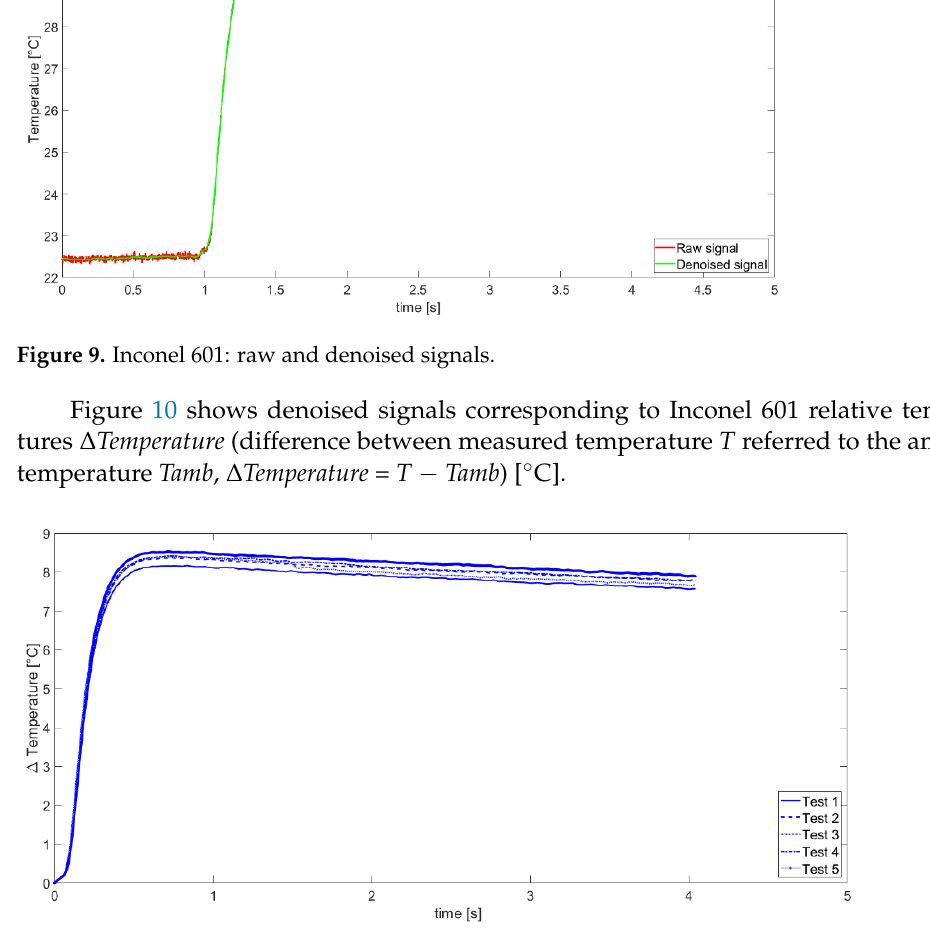
Figure 10. Inconel 601: relative temperature ∆ Temperature.